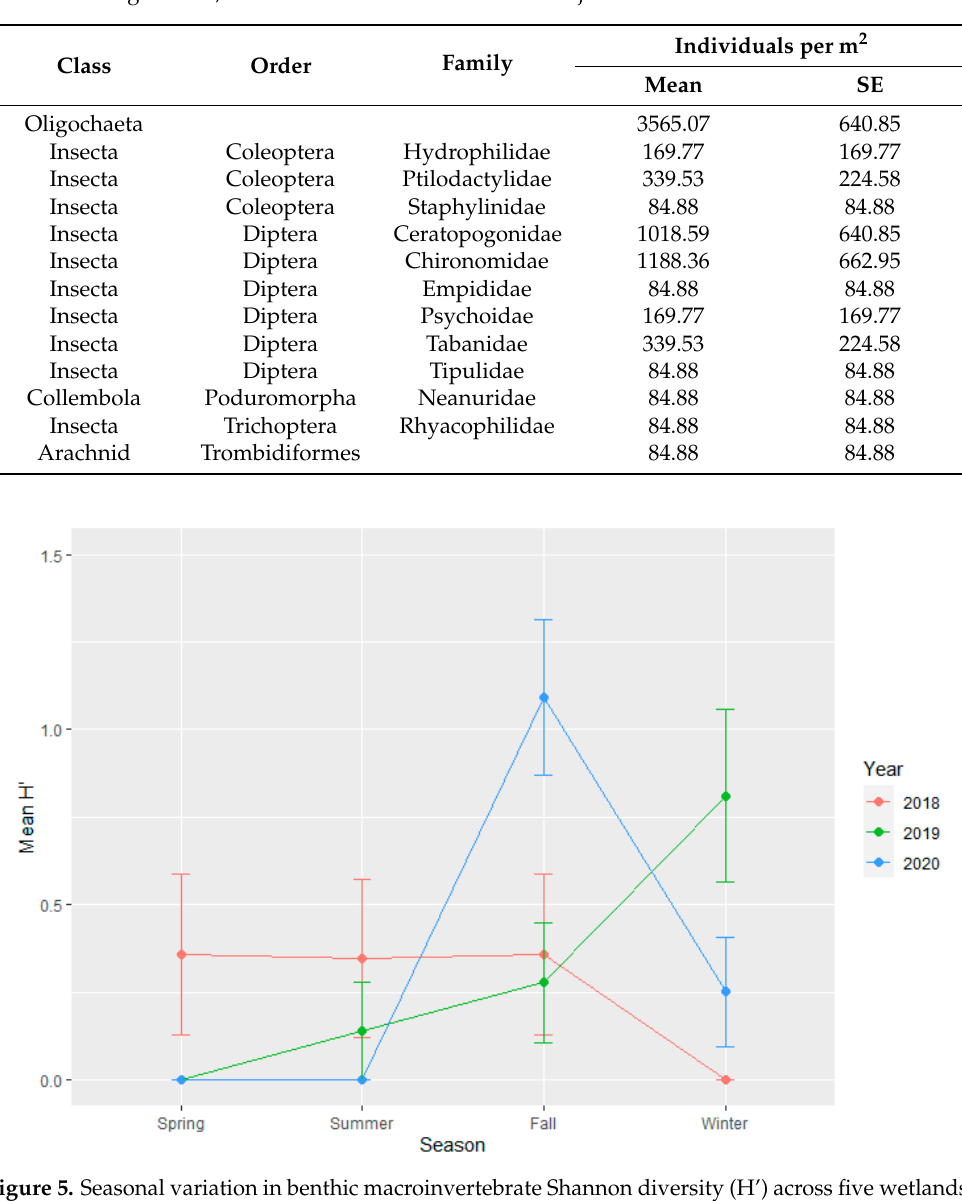
Table 2. Benthic macroinvertebrate assemblages across five locations within the Ruby Run riparian zone at J.W. Ruby Research Farm in Preston County, West Virginia, USA, from 2018 to 2020. Relative abundance was calculated as number of individuals per square meter. All taxa were larval forms aside from Oligochaeta, which consisted of both adults and juveniles.